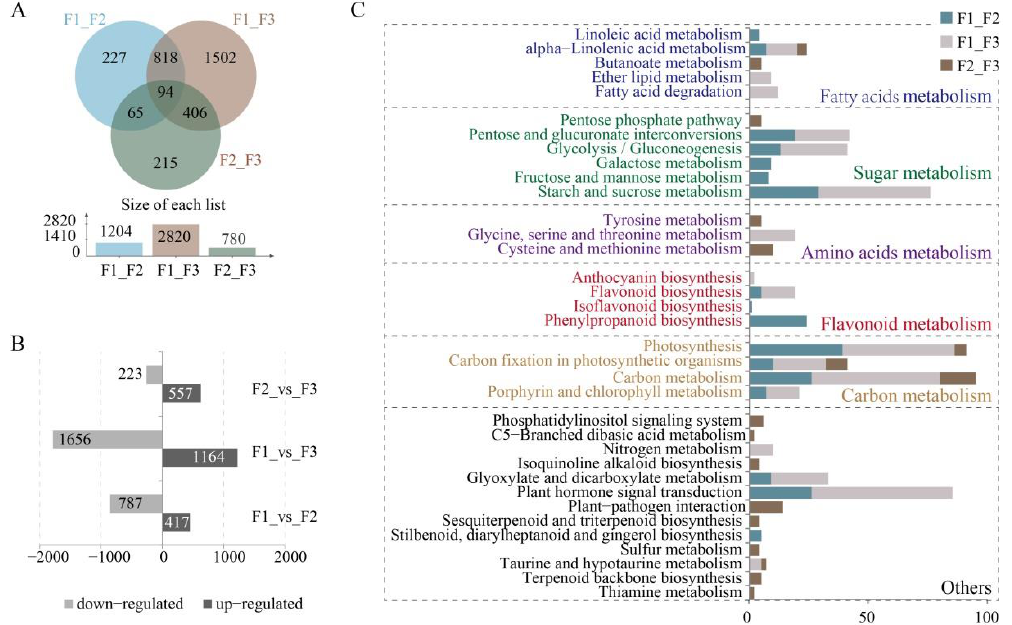
Figure 4. Transcriptomic-based gene identification and DEG analyses. ( A ) Venn diagram showing shared genes among each group. ( B ) Up- and down-regulated DEGs of each comparison group. ( C ) Kyoto Encyclopedia of Genes and Genomes (KEGG) classification of DEGs.